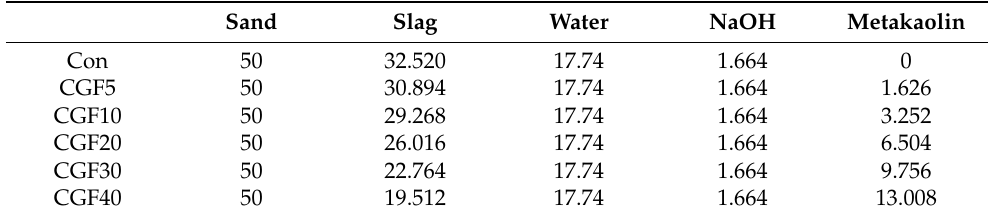
Table 2. Experimental mix proportion (g/100